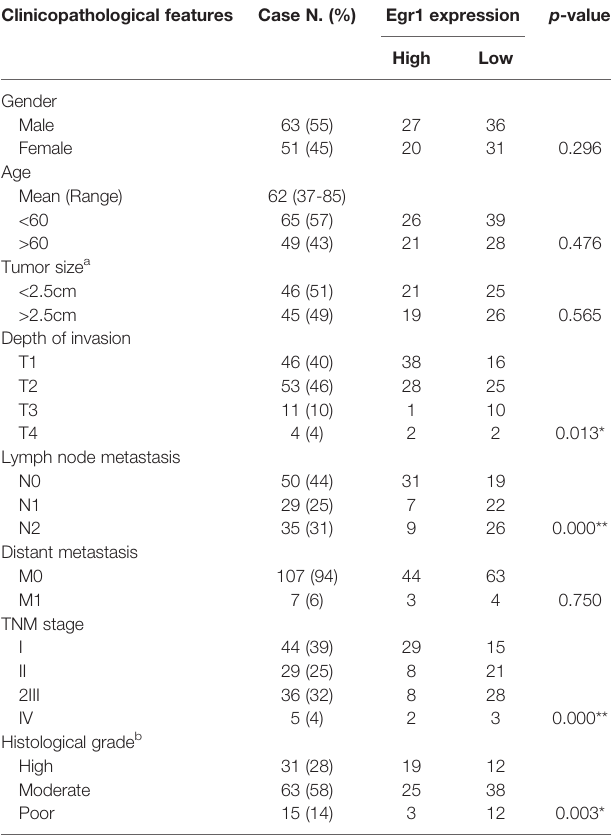
TABLE 1 | Association of immunohistochemical staining for EGR1 with the tumor clinic pathological characteristic. Clinicopathological features Case N.